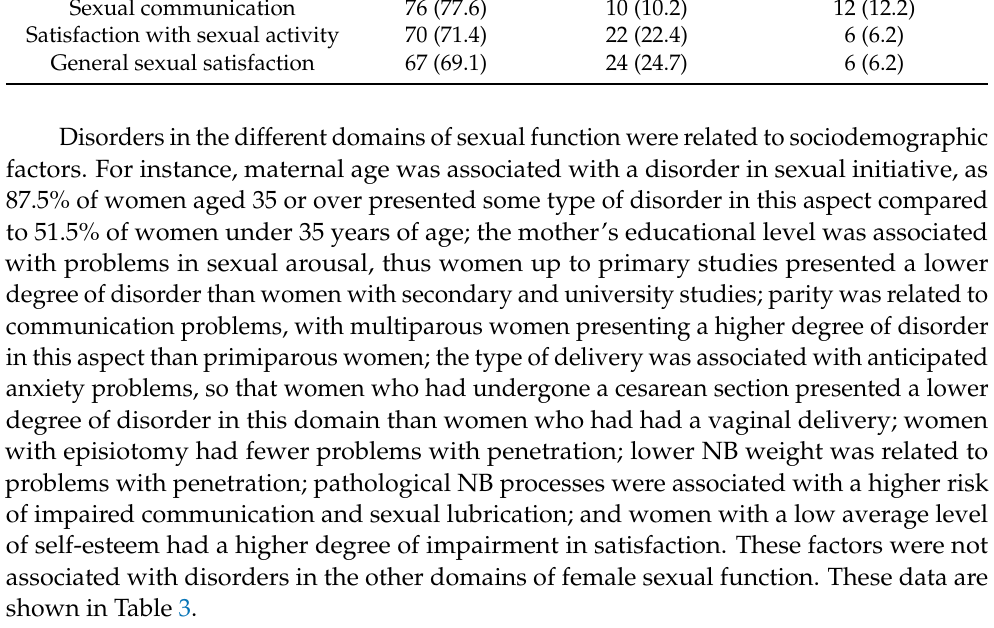
Table 3. Disorders in sexual function according to sociodemographic and perinatal factors.